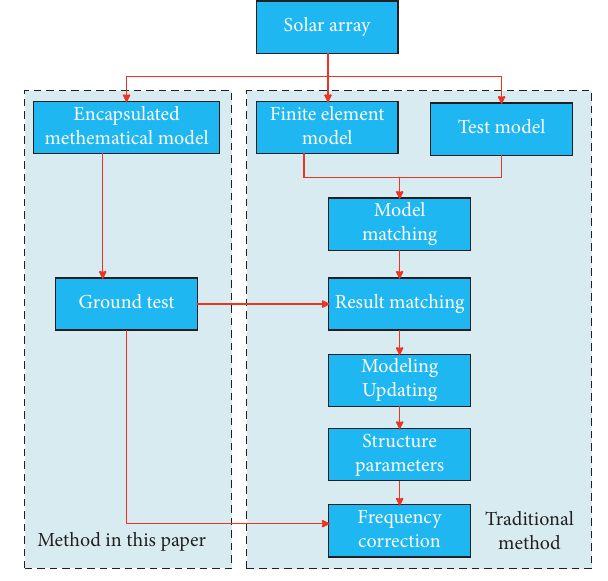
Figure 6: Process